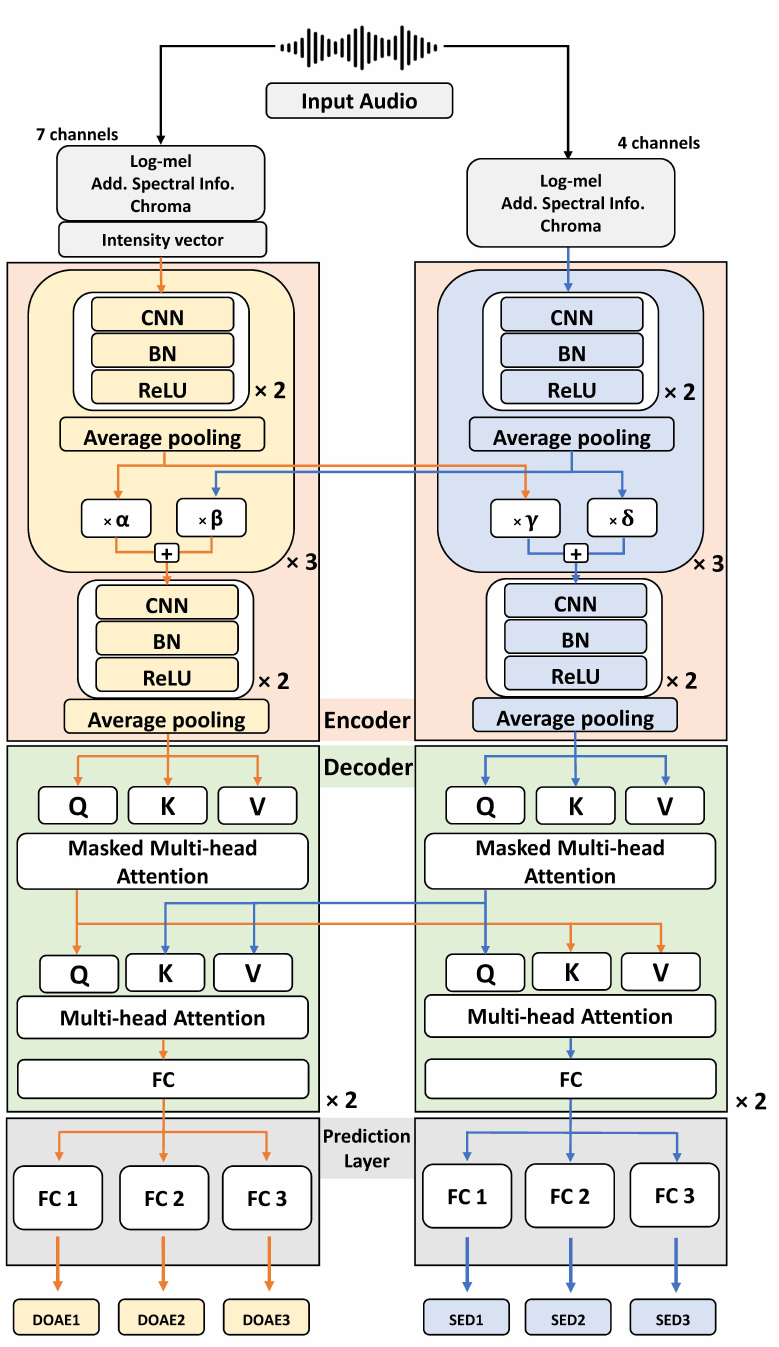
Figure 2. The overall DCMA-SELD architecture. Q, K, and V indicate the query, key, and value in the attention,